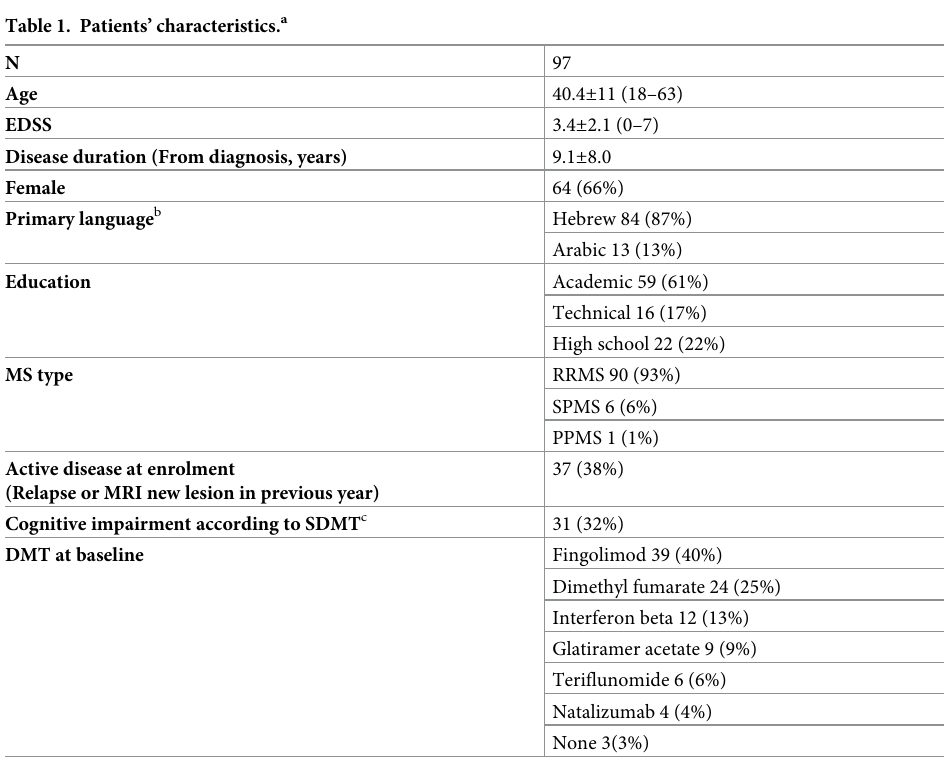
Table 1. Patients’ characteristics.